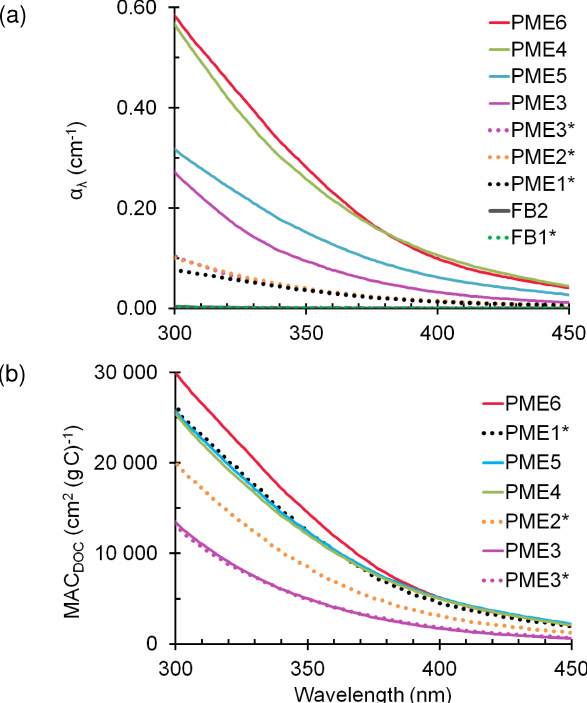
Figure 1. (a) Light absorption coefficients, α λ , in particulate matter extracts (PME) (Eq. 1) and field blanks (FB). The legend shows the sample identities, arranged from the highest absorbing (top) to low- est absorbing (bottom) at 300nm. Solid and dotted lines represent standard and dilute extracts, respectively (with the latter indicated with an asterisk; Sect. 2.2). (b) Mass absorption coefficients of DOC in the particle extracts (Eq.